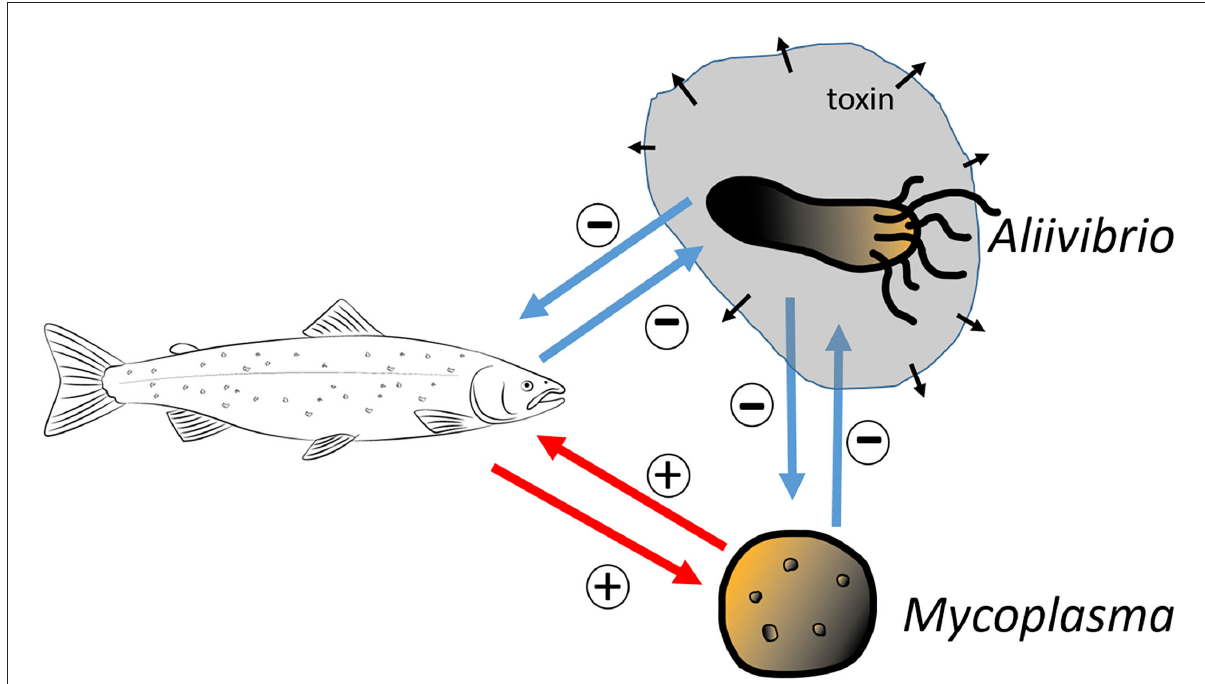
FIGURE2 A conceptual schematic of the model. The salmon and Mycoplasma engaged in mutualistic interaction with each other ( + signs at the red arrows). Conversely, the toxin-producing Aliivibrio harms the salmon, which in turn defends itself via its immune response (– signs at the blue arrows). The Mycoplasma and Aliivibrio species of the model compete for the same niches and resources so that the expansion of one species is at the expense of the other species (– signs at the blue